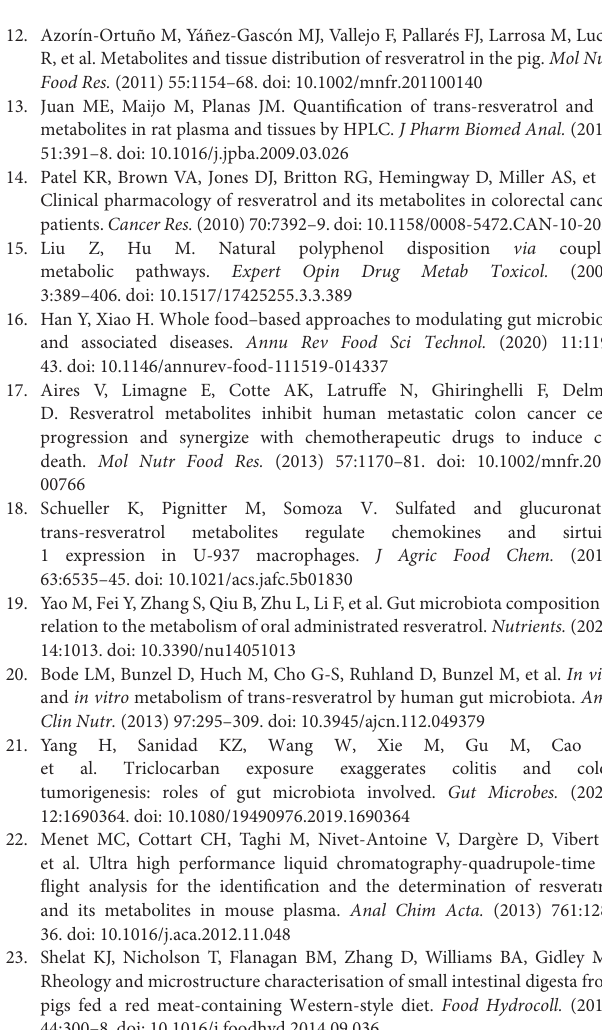
Supplementary Figure 1 | Representative images of 786-O (A) colonies and A498 (B) colonies after various treatments. Supplementary Figure 2 | Anti-proliferative effects of DHR and LUN in CCD-18Co cell line with concentrations equivalent to 1.5 times that measured in colonic tissues (A) . Representative images of HT29 (B) colonies. At the indicated concentrations, RES showed stronger inhibitory effects on NO production compared to DHR and LUN (C) . Three independent experiments were conducted. Data presented as mean ± SEM. Significant differences are indicated: ∗ , P <